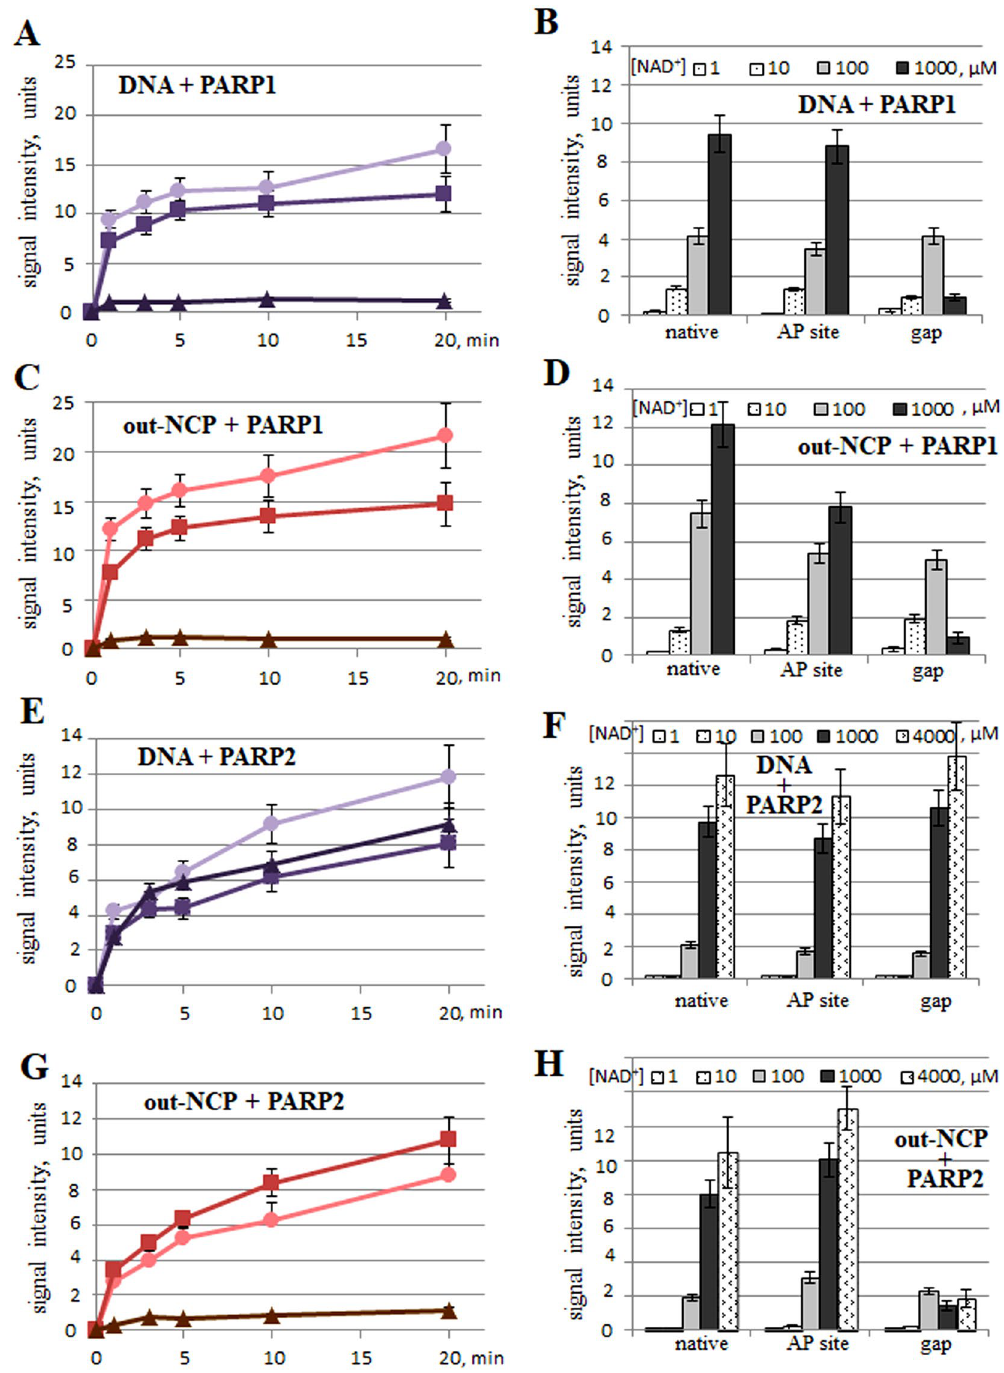
Figure 2. The activation of PARP1 and PARP2 by DNA or an NCP as measured by the amount of a poly(ADP- ribose) synthesised by PARP1 or PARP2 using [ 32 P]labelled NAD + as a precursor. The graphs in panels ( A – D ) deal with PARP1 activation. The graphs in panels ( E – H ) are about PARP2 activation. In all the graphs, the data obtained with a native substrate are indicated by (circle), with AP-NCP by (square) and with gap-NCP by (triangle). The graphs in panels in the left part represent the accumulation kinetics of PAR at 1000 μM NAD + ; the histograms in panels in the right part represent the total amount of PAR synthesised by PARP1 for 1 min or by PARP2 for 3 min at NAD + concentrations 1–1000 μM or 1–4000 μM, respectively. In all the graphs, the experimental data on DNA substrates are characterised by black, reddish-violet or violet curves; the NCP substrates correspond to the red or yellowish-green curves. The data are presented as an average of at least three independent experiments and are shown as the mean ± SD. The reactions were carried out as described in “Materials and